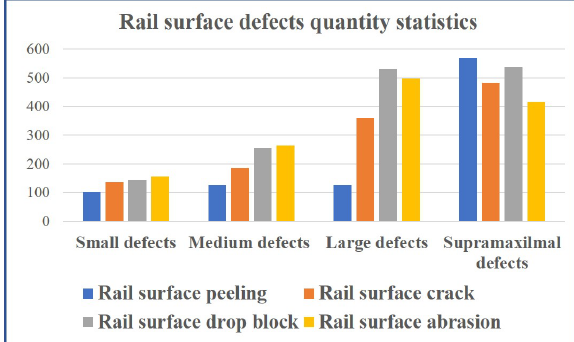
Fig. 3. Statistical diagram of rail surface defects.